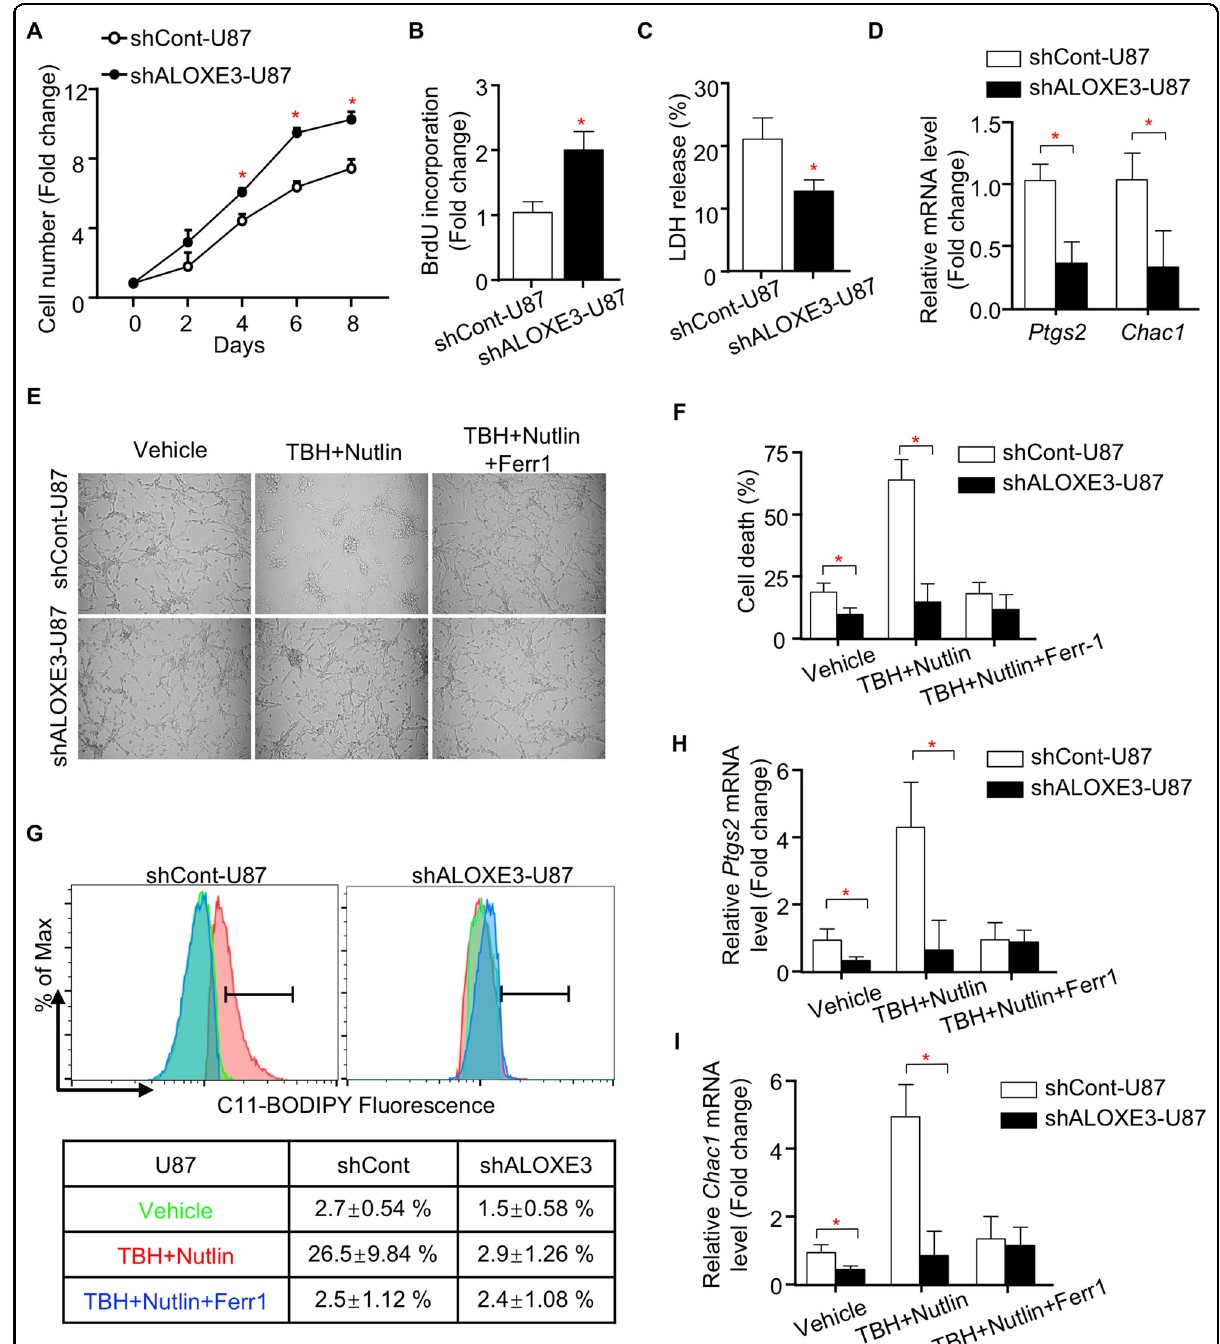
Fig. 3 GBM cells with ALOXE3 silencing are resistant to p53-induced ferroptosis. A – D shALOXE3-U87 and shCont-U87 cells were used ( n = 6). A Cell number was determined by trypan blue assay at indicated time points. B BrdU incorporation of cells. C LDH release of cells. D Relative mRNA levels of Ptgs2 and Chac1 normalized with GAPDH in cells. E – I shALOXE3-U87 and shCont-U87 cells were pre-treated with Nutlin-3a for 12 h and followed with TBH and Nutlin-3a± Ferr1 treatment for additional 8 h ( n = 6). E Representative images of cells. F Trypan blue staining for cell death. G C11-BODIPY staining for lipid peroxidation. H , I Relative mRNA levels of ( H ) Ptgs2 and ( I ) Chac1 normalized with GAPDH in cells. All data are represented as the mean ± s.e.m. * p < 0.05 (Student ’ s t test).